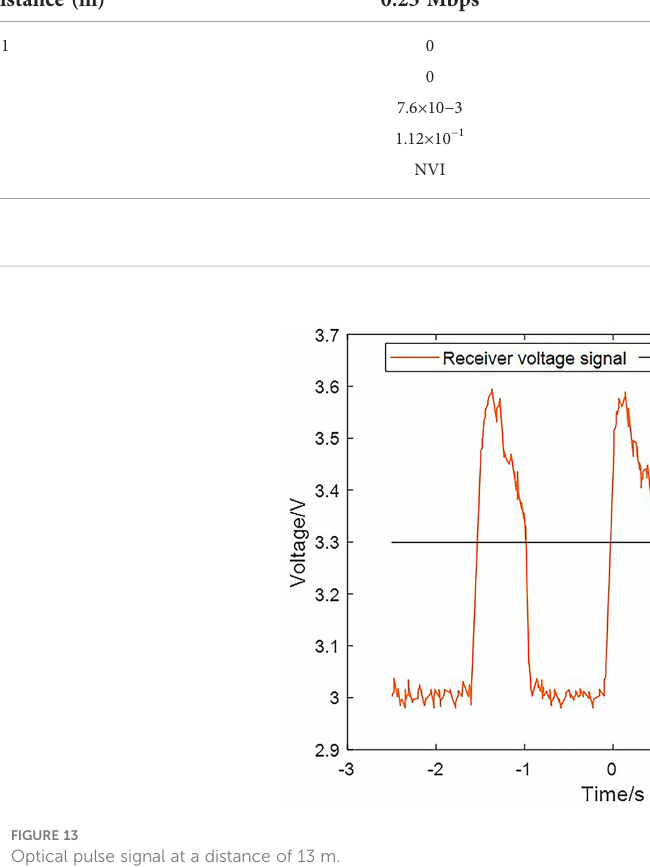
TABLE 3 Bit error rates for different distances and communication rates. Distance (m)